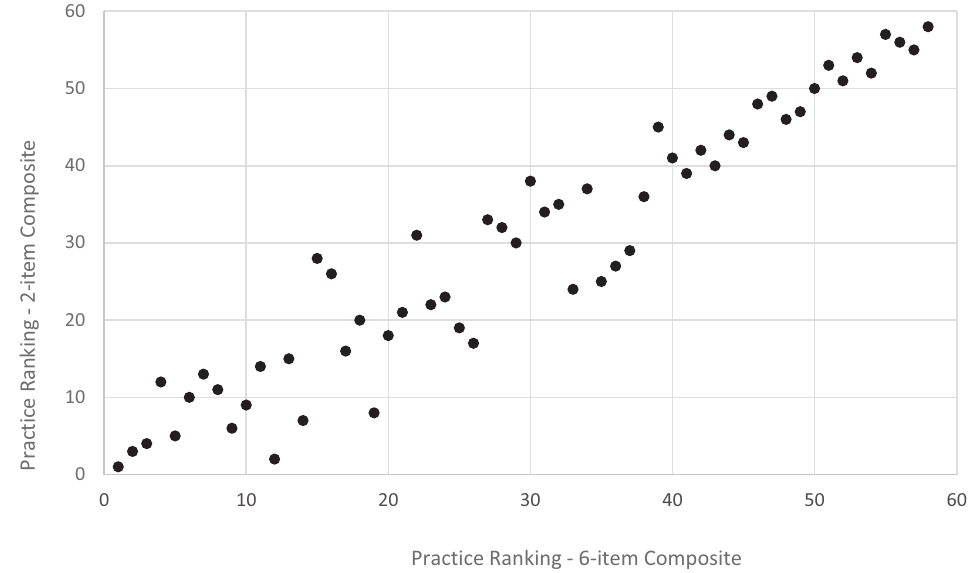
Figure 5. Practice ranking, revised vs . original child access composite, CAHPS PCMH 2013 ( n = 58 practices).